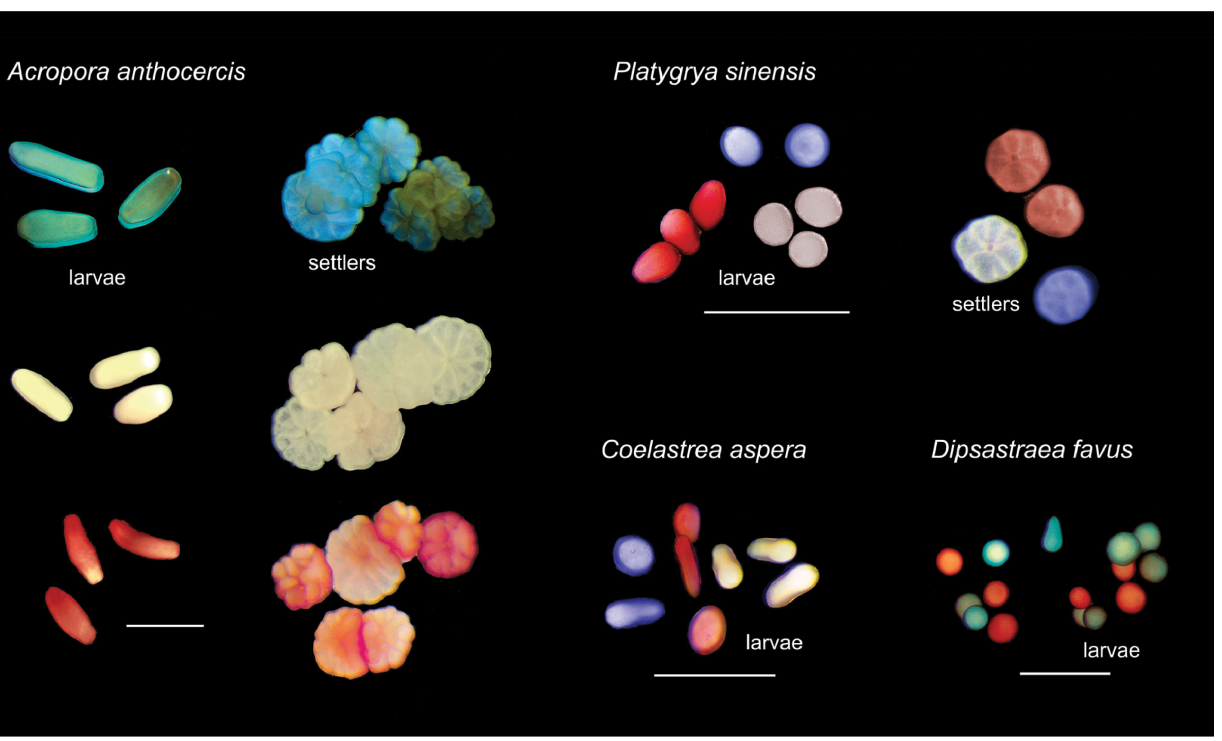
PLOS Biology | https://doi.org/10.1371/journal.pbio.3001907 December 6,